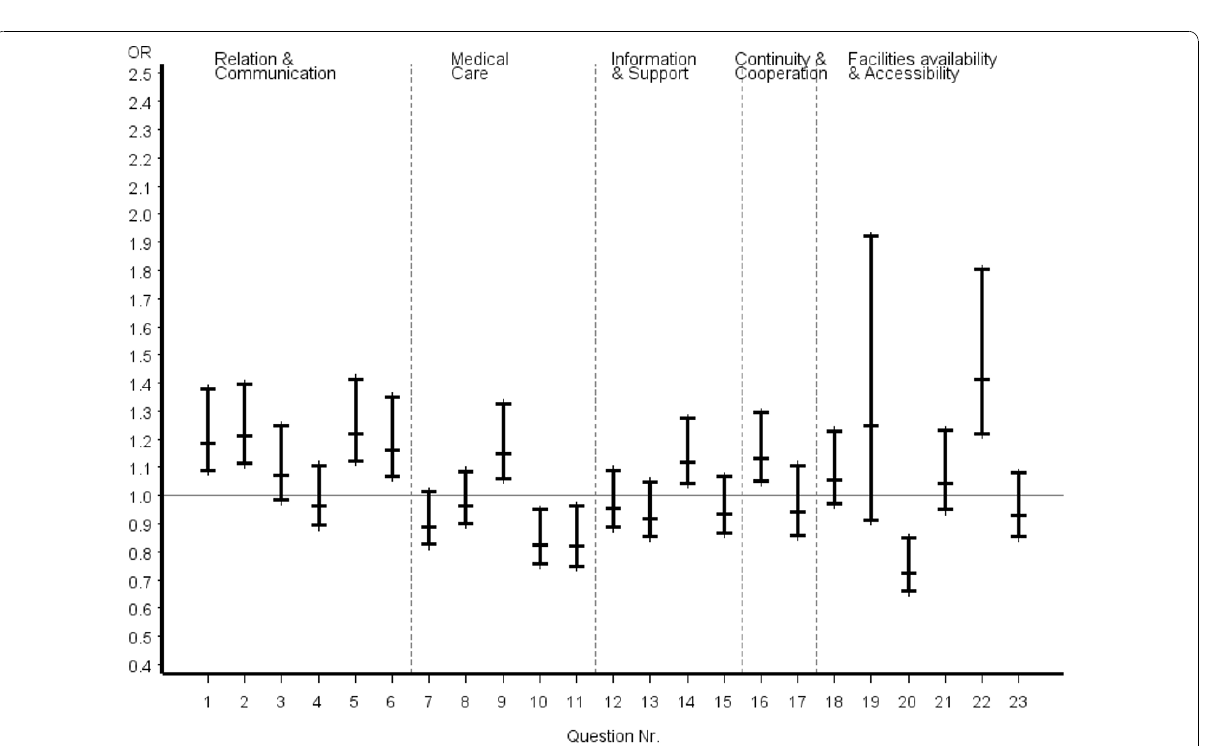
Figure 6 ..Europep questionnaire, odds ratios of most favourable answer option (certified CAM vs. COM) Stratified analysis of patients with university degrees . Errorbars denote 95% confidence intervals of odds